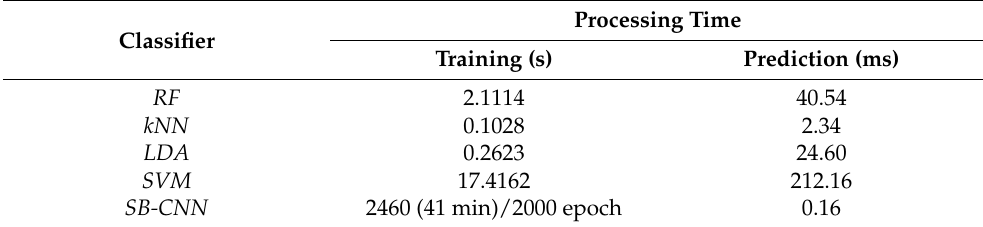
Table 2. Processing Time of Train and Prediction for Each